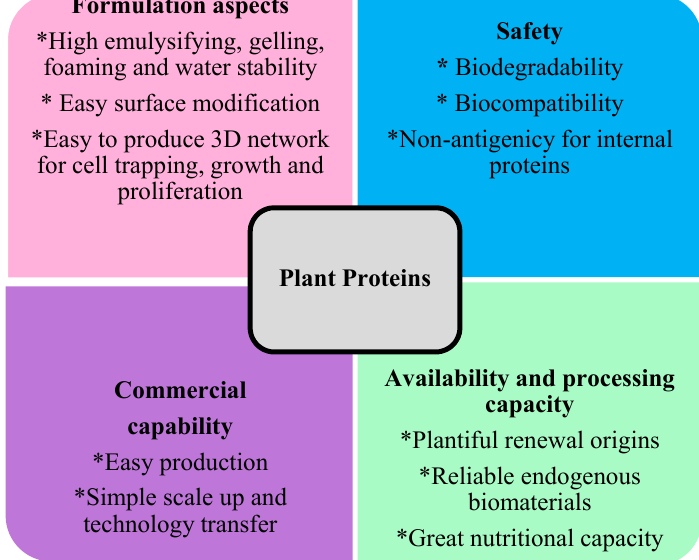
Figure 2. Attractive aspects of plant proteins for biomedical applications. 3D: three-dimensional.